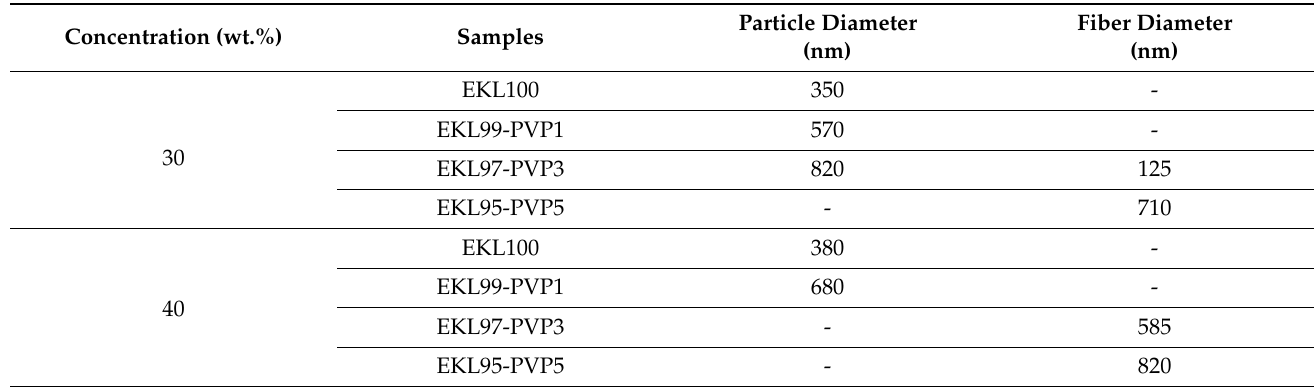
Table 3. Average particle and fiber diameters of the different micro- and nano-structures obtained by electrohydrodynamic processing.